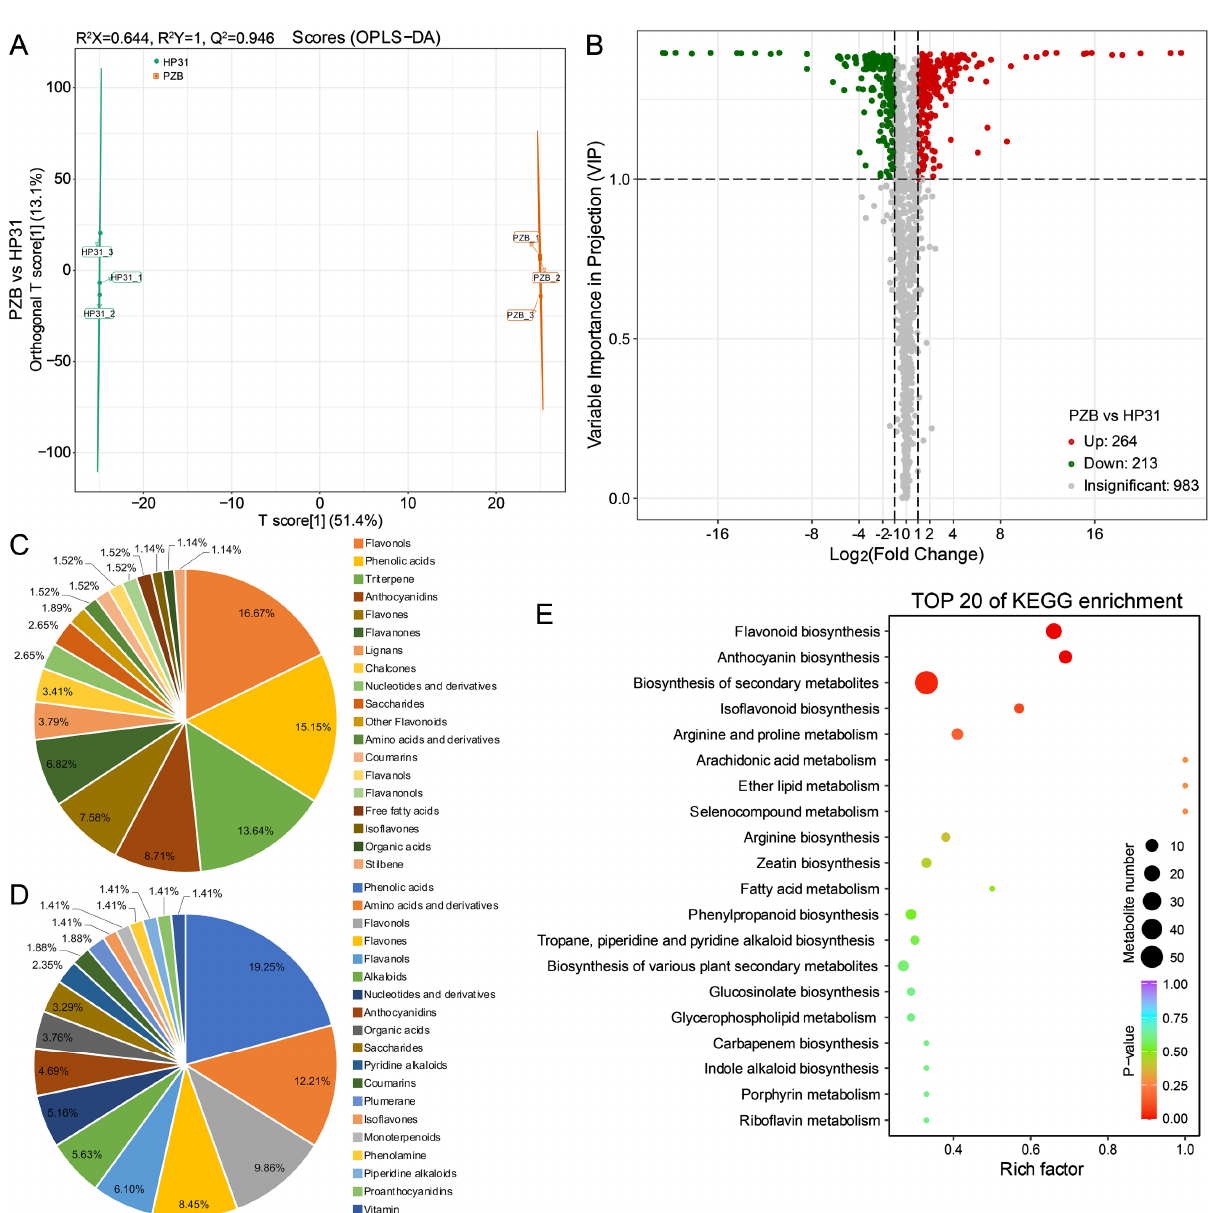
Figure 5. Overall analysis of the metabolomics data between dark ‐ red and yellow fruits of Chinese cherry. ( A ) OPLS ‐ DA. ( B ) Volcano plots of the metabolic profile in dark ‐ red and yellow fruits. ( C , D ) Type and number of up ‐ regulated and down ‐ regulated metabolites. The TOP 19 types of DEMs were shown here. ( E ) TOP 20 of KEGG enrichment in the differential metabolites.